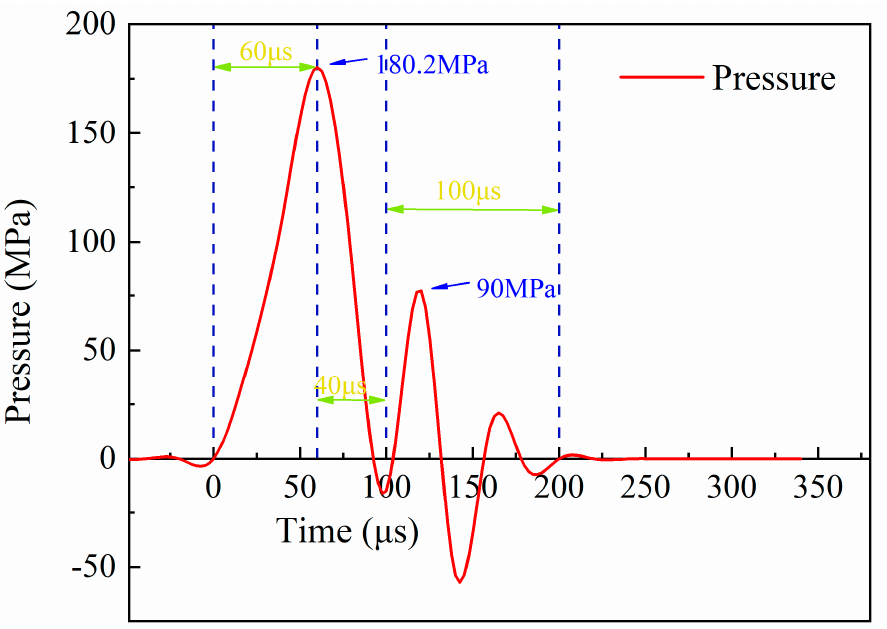
Figure 7. Fracturing tube’s internal p-t curve.